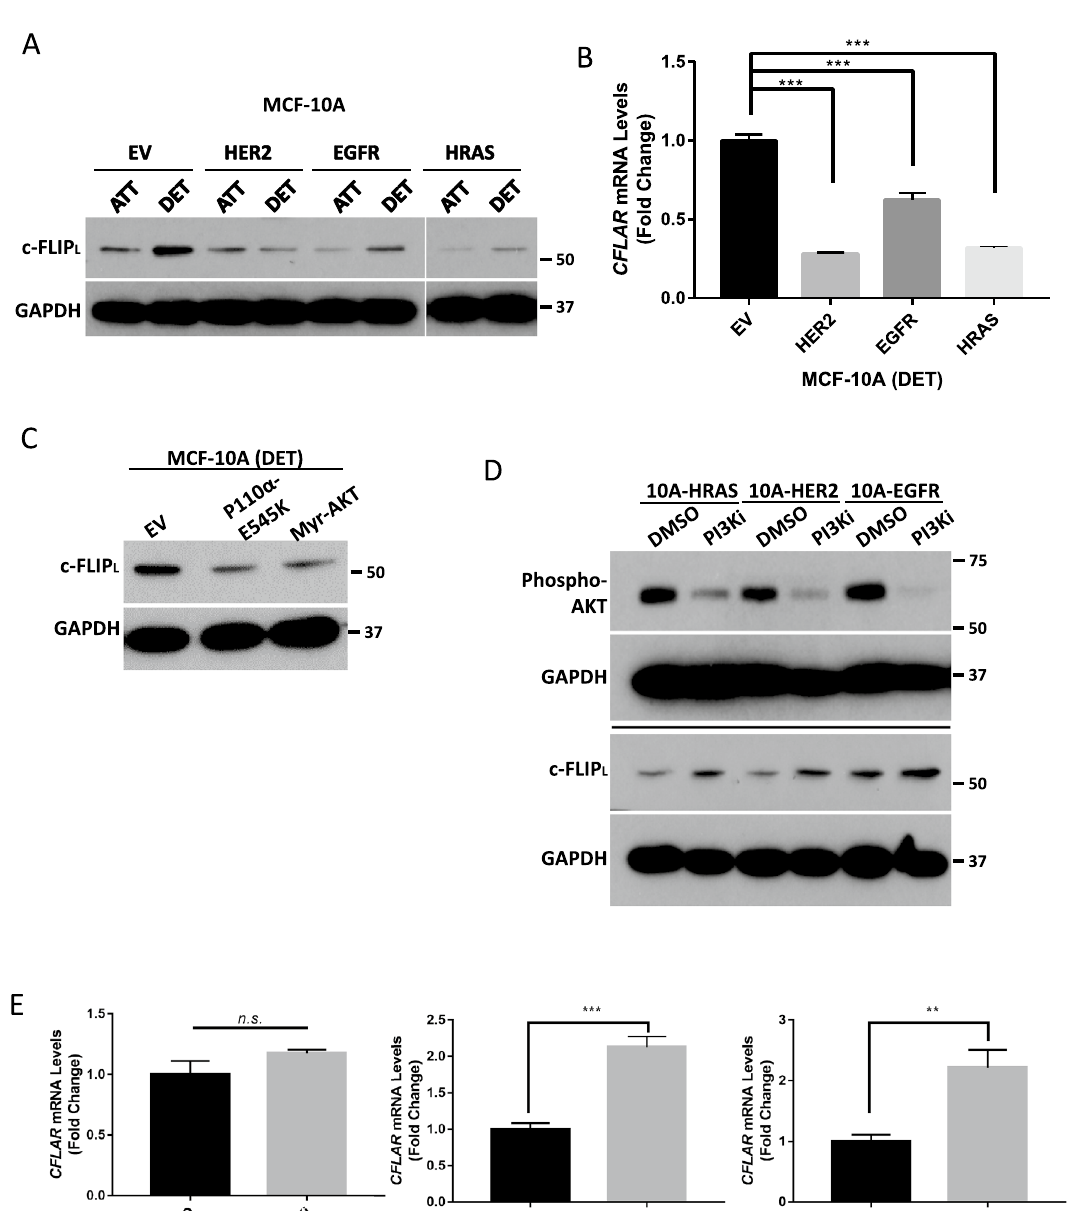
Figure 3. Regulation of c-FLIP L by PI(3)K/Akt signaling during ECM-detachment. ( A ) Measurement of c-FLIP L protein levels (in detached and attached conditions) in MCF-10A cells overexpressing oncogenes (HRAS G12V , HER2, EGFR) as compared to empty vector (EV) control. ( B ) RT-qPCR measurement of CFLAR in MCF-10A cells overexpressing oncogenes versus EV control. ( C ) Measurement of c-FLIP L protein levels in MCF-10A cells overexpressing oncogenes (p110α E545K and myr-AKT) as compared to EV control. ( D ) Measurement of c-FLIP L levels after treatment of oncogene overexpressing MCF-10A cells with small molecule inhibitor of PI3Kα, BYL719 (10 μM). ( E ) Measurement of CFLAR levels in oncogene overexpressing MCF-10A cell treated with BYL719. Graphs show representative data from a minimum of three biological replicates and all western blotting experiments were independently repeated a minimum of three times with similar results. Statistical significance was determined using Student’s two-tailed t test. Error bars show standard deviation. All panels show cells grown in ECM-detached